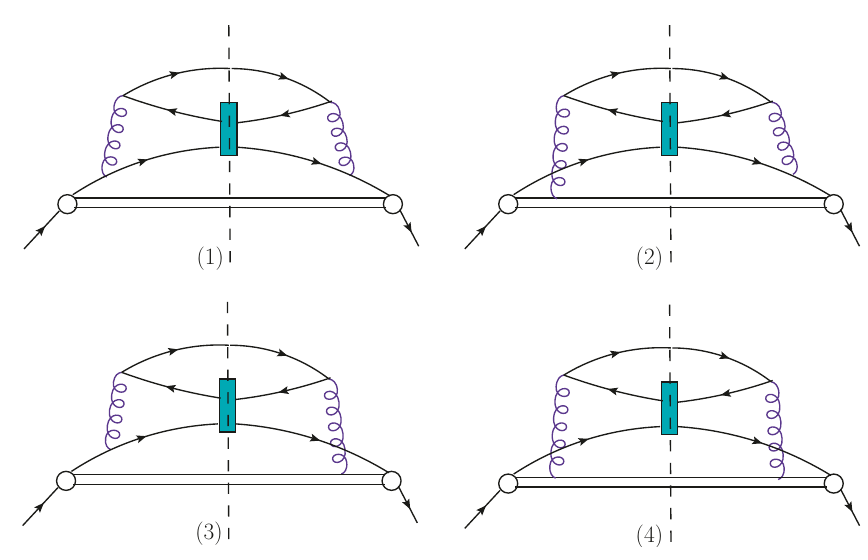
Figure 1 . The LO cut diagrams for the fragmentation function D